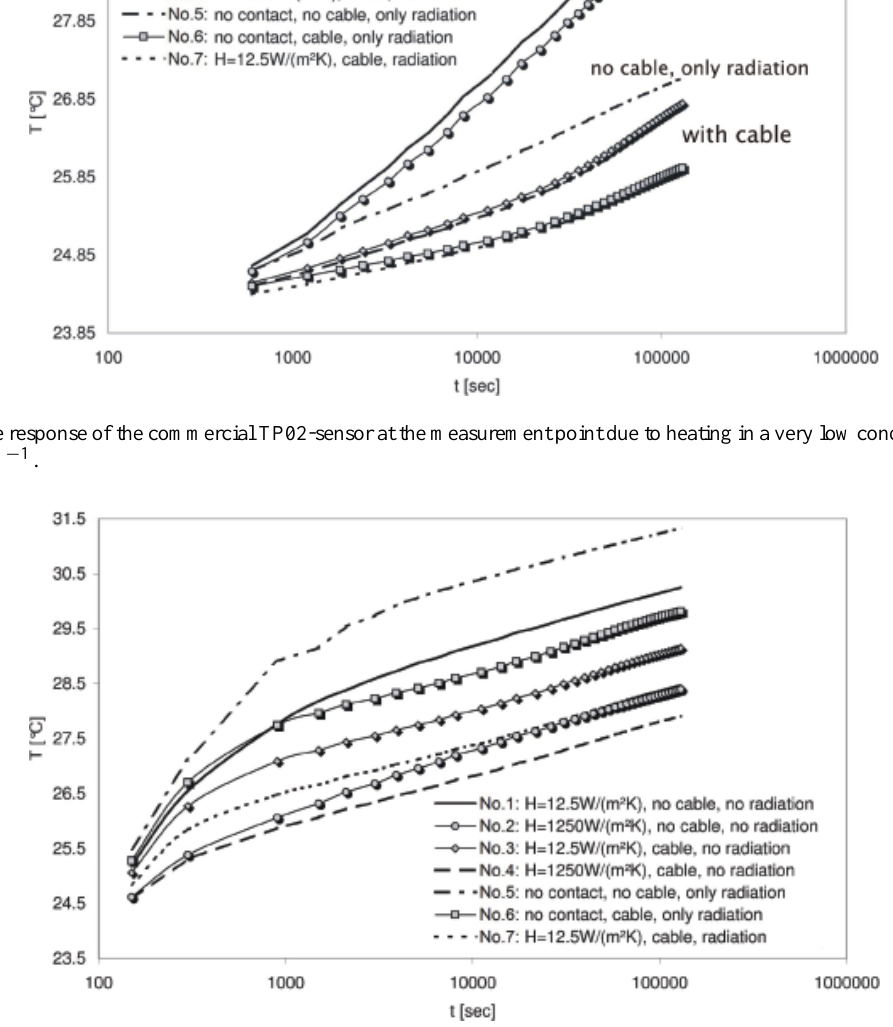
Fig. 10. Temperature response of the commercial TP02-sensor at the measurement point due to heating in a low conductivity sample with λ = 0 . 02Wm − 1 K − 1